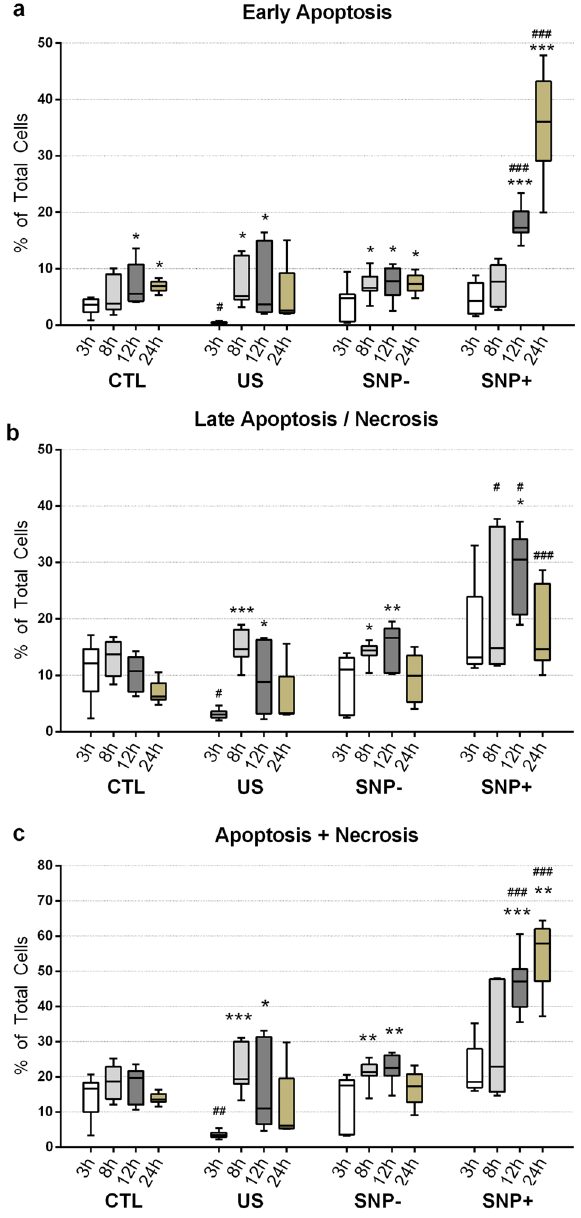
Figure 2. Cytotoxicity trends at different post-exposure time points (3 h to 24 h) for sonoporated (SNP+) and unsonoporated cells (SNP–) that were initially viable after exposure. Each box-whisker plot shows, for each sorted cell group, the percentage of cells in (a) early apoptosis, (b) late apoptosis or necrosis (i.e. dead), and (c) either death pathway (i.e. sum of apoptosis and necrosis). Results are also shown for sham exposure cells (CTL) and cells that were sonicated in the absence of microbubbles (US) ( N = 9; *,**, and *** respectively denote p <0.05, p <0.01, and p <0.001 versus the 3 h time point of the same group. # and ### respectively denote p <0.05 and p<0.001 versus CTL at the corresponding time